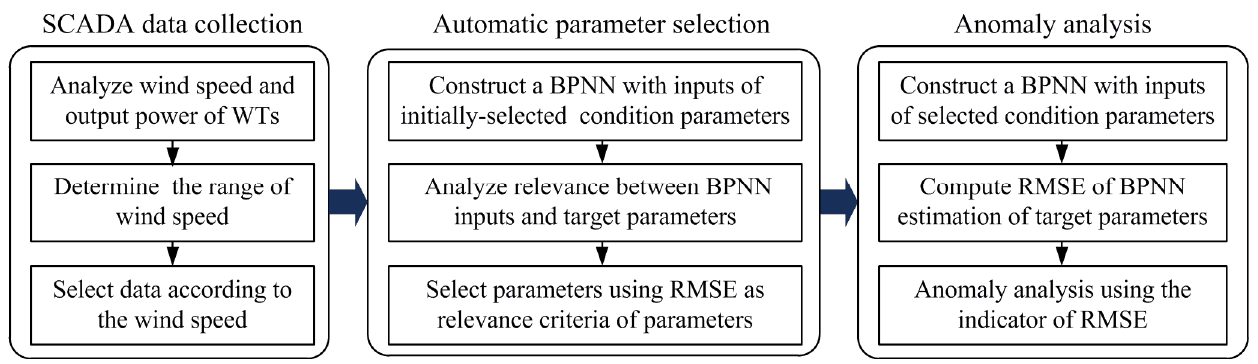
Figure 1. Schematic of the APS-based model.